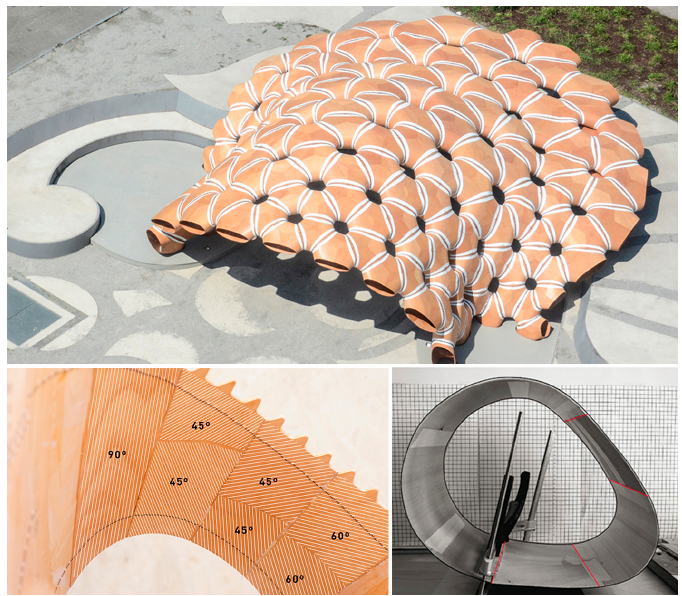
Figure 3. ICD/ITKE Research Pavilion 2015-16: Segmented timber shell and custom lamination of timber veneer to achieve specific bending and strength requirements of architectural shell elements [22].